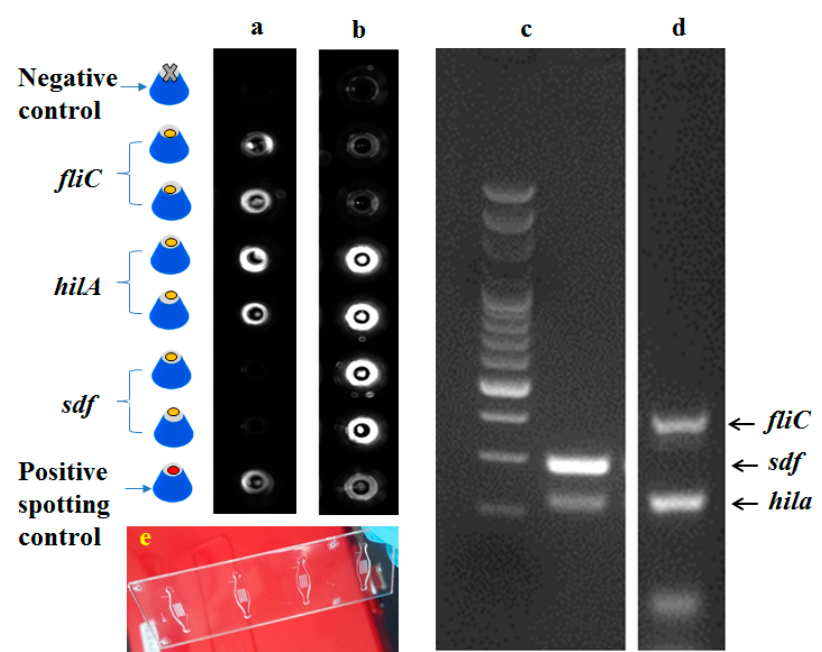
Figure 10. ( a )( b ) Fluorescent images from the fluorescent scanner BioAnalyzer 4F/4S (LaVisionBiotec GmbH, Bielefeld, Germany) for multiplexed SP-PCR to detect and differentiate S . Typhimurium and S . Enteritidis. ( c )( d ) The gel image of liquid phase PCR products. ( e ) Polymer microchip with an array of SAF structures.